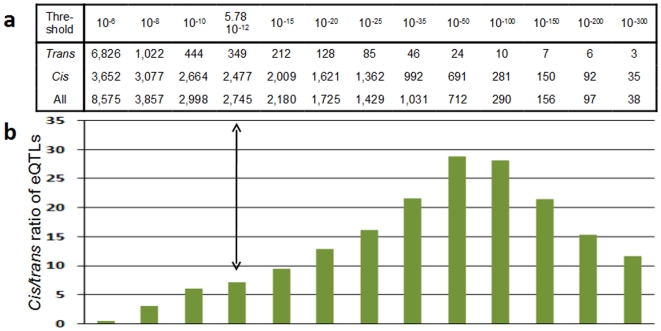
Number of eQTLs according to the significance threshold adopted and corresponding cis/trans eQTL ratio.The vertical arrow indicates the study-wise level of significance correcting for the number of hypotheses tested. Some eQTLs being associated with both cis and trans-acting eSNPs, the sum of cis and trans eQTLs is greater than the total number of eQTLs.